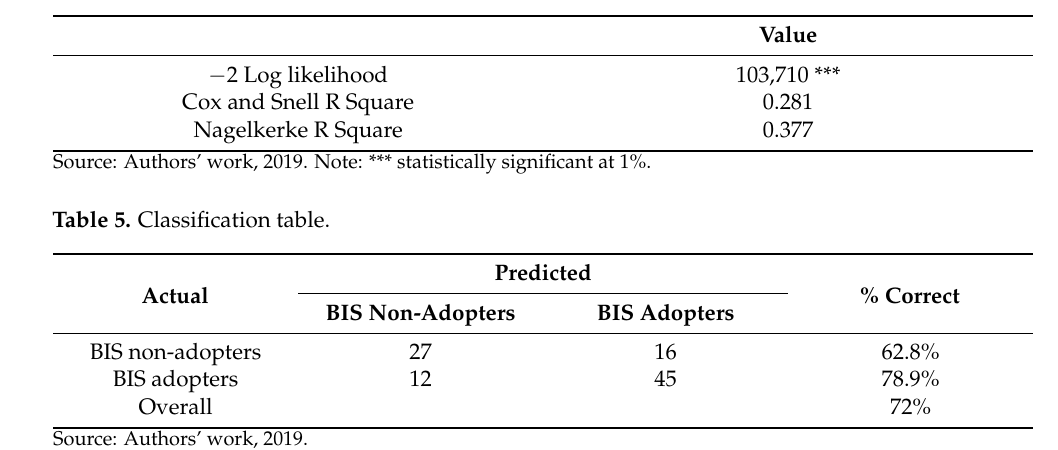
Table 4. Goodness-of-fit of the research model.